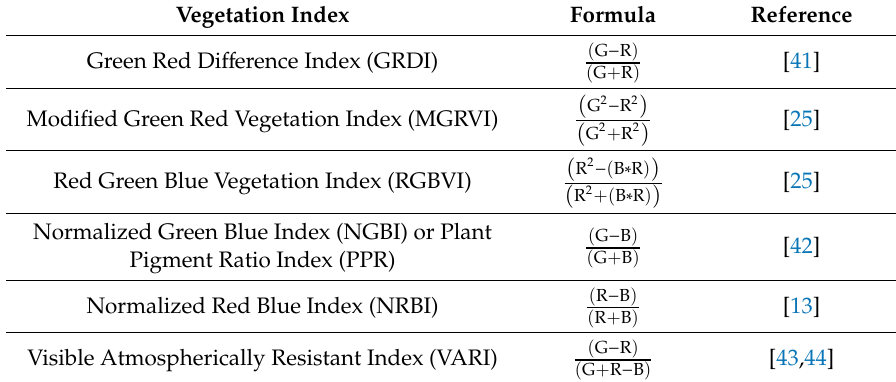
Table 2. Vegetation indices computed from the RGB imagery (FC220 for Mavic and FC6310 for Phantom 4). R: red; G: green; B: blue. Each layer was divided by the associated brightness (i.e., the mean value of all